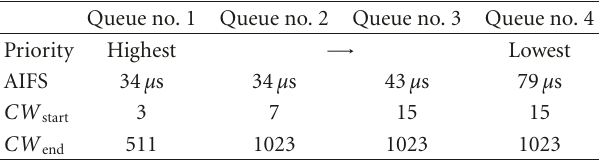
Table 1: Default parameter settings in 802.11p for the di ff erent